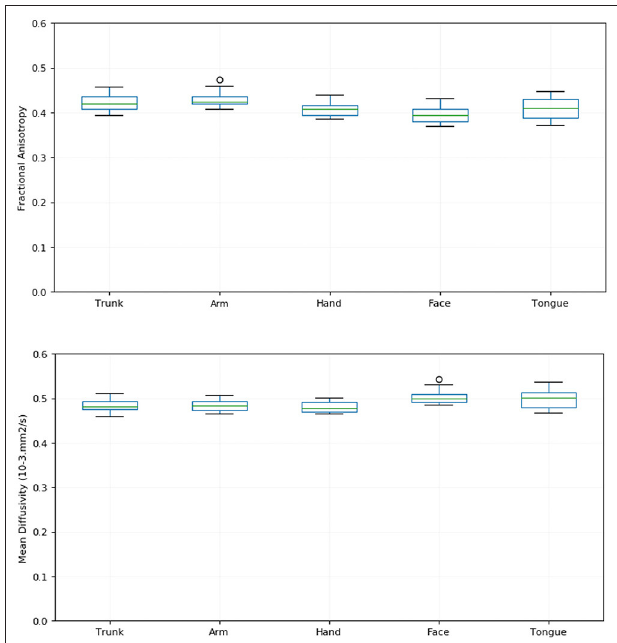
FIGURE 3 | Tract-derived measurements across subjects. The figure shows box plots of the fractional anisotropy (FA) (top) and mean diffusivity (MD) (bottom) of hyperdirect pathway fascicles projecting from the trunk, arm, hand, face, and tongue motor area for all subjects. The lines in each box correspond to the median (green), interquartile range (blue), minimum and maximum (black) values of the tract-derived measurements.